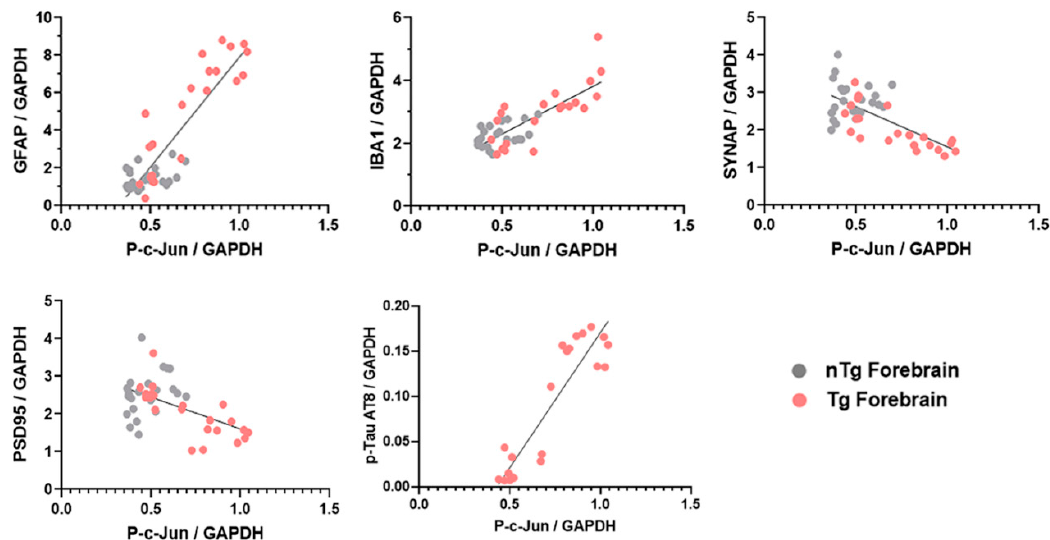
Figure 6. Correlation of p-c-Jun with neuronal injury markers and synaptic markers in rTg4510 mouse brain. Correlation plots between the amount of GFAP / GAPDH (R 2 = 0.78), IBA1 / GAPDH (R 2 = 0.63), SYNAP / GAPDH (R 2 = 0.46), PSD-95 / GAPDH (R 2 = 0.28), and p-TAU AT8 / GAPDH (R 2 = 0.83) with p-c-Jun / GAPDH in forebrain of nTg and Tg mice. Grey circles, nTg; pink circles, Tg; p < 0.0001, Pearson correlation.